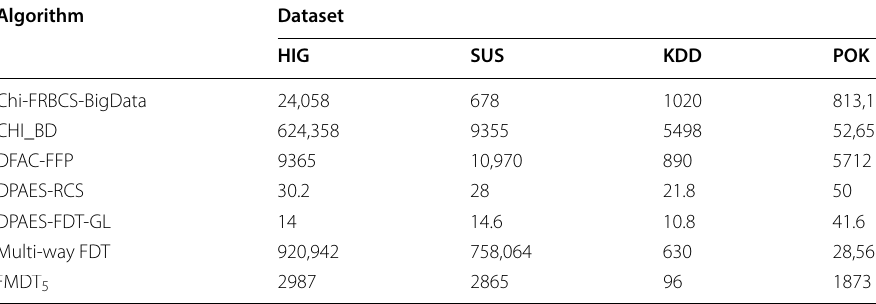
Table 4 Experimental comparison: average complexities